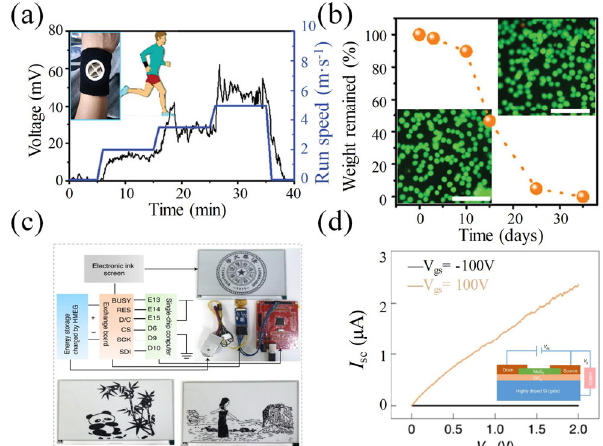
Figure 9 Bio-inspired water-driven self-powered electronics. (a) Portable perspiration-driven self-powered sensor. (b) Mass change during degradation of biologic electricity generator in soil. (a) and (b) Reproduced with permission from Ref. [123], © Wiley-VCH Verlag 2019. (c) Schematic of self-powered electronic ink display. (d) Schematic of self-powered field effect transistor. (c) and (d) Reproduced with permission from Ref. [124], © Wang, H. Y. et al.